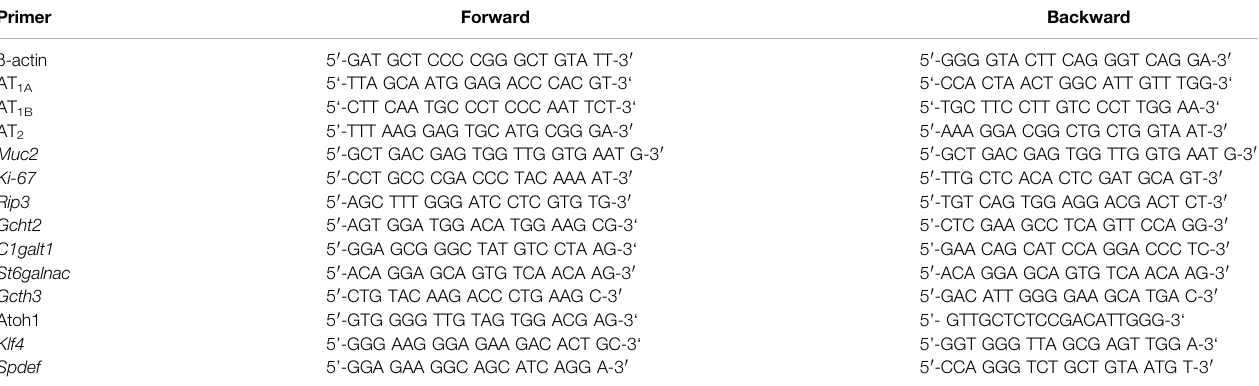
TABLE 1 | Primer sequences. Primer